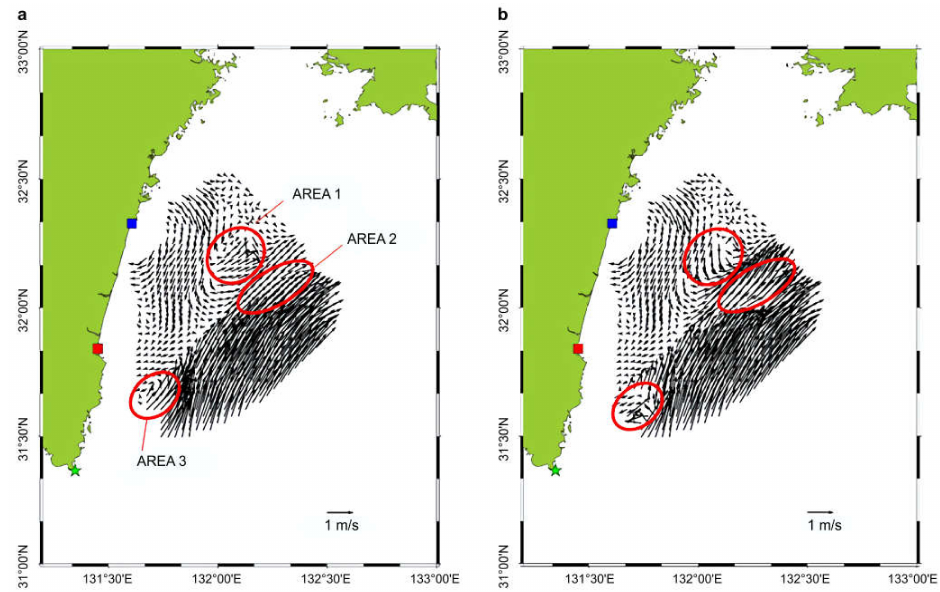
Figure 14. Mapping results of current velocities at 14:00 on 8 March 2019. In AREA1 and AREA2, the radial velocities obtained from the two peaks observed at Miyazaki Station and the first peak